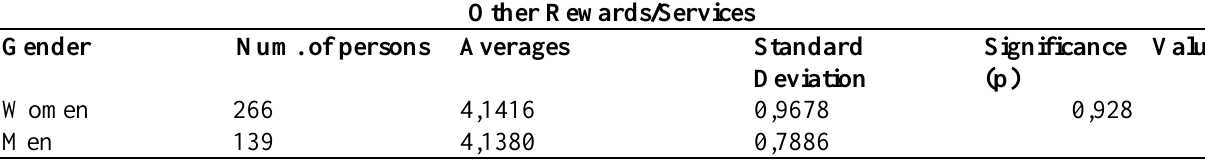
Table 10. Comparison of the views on the perception of the rewards/services offered under the FFP by